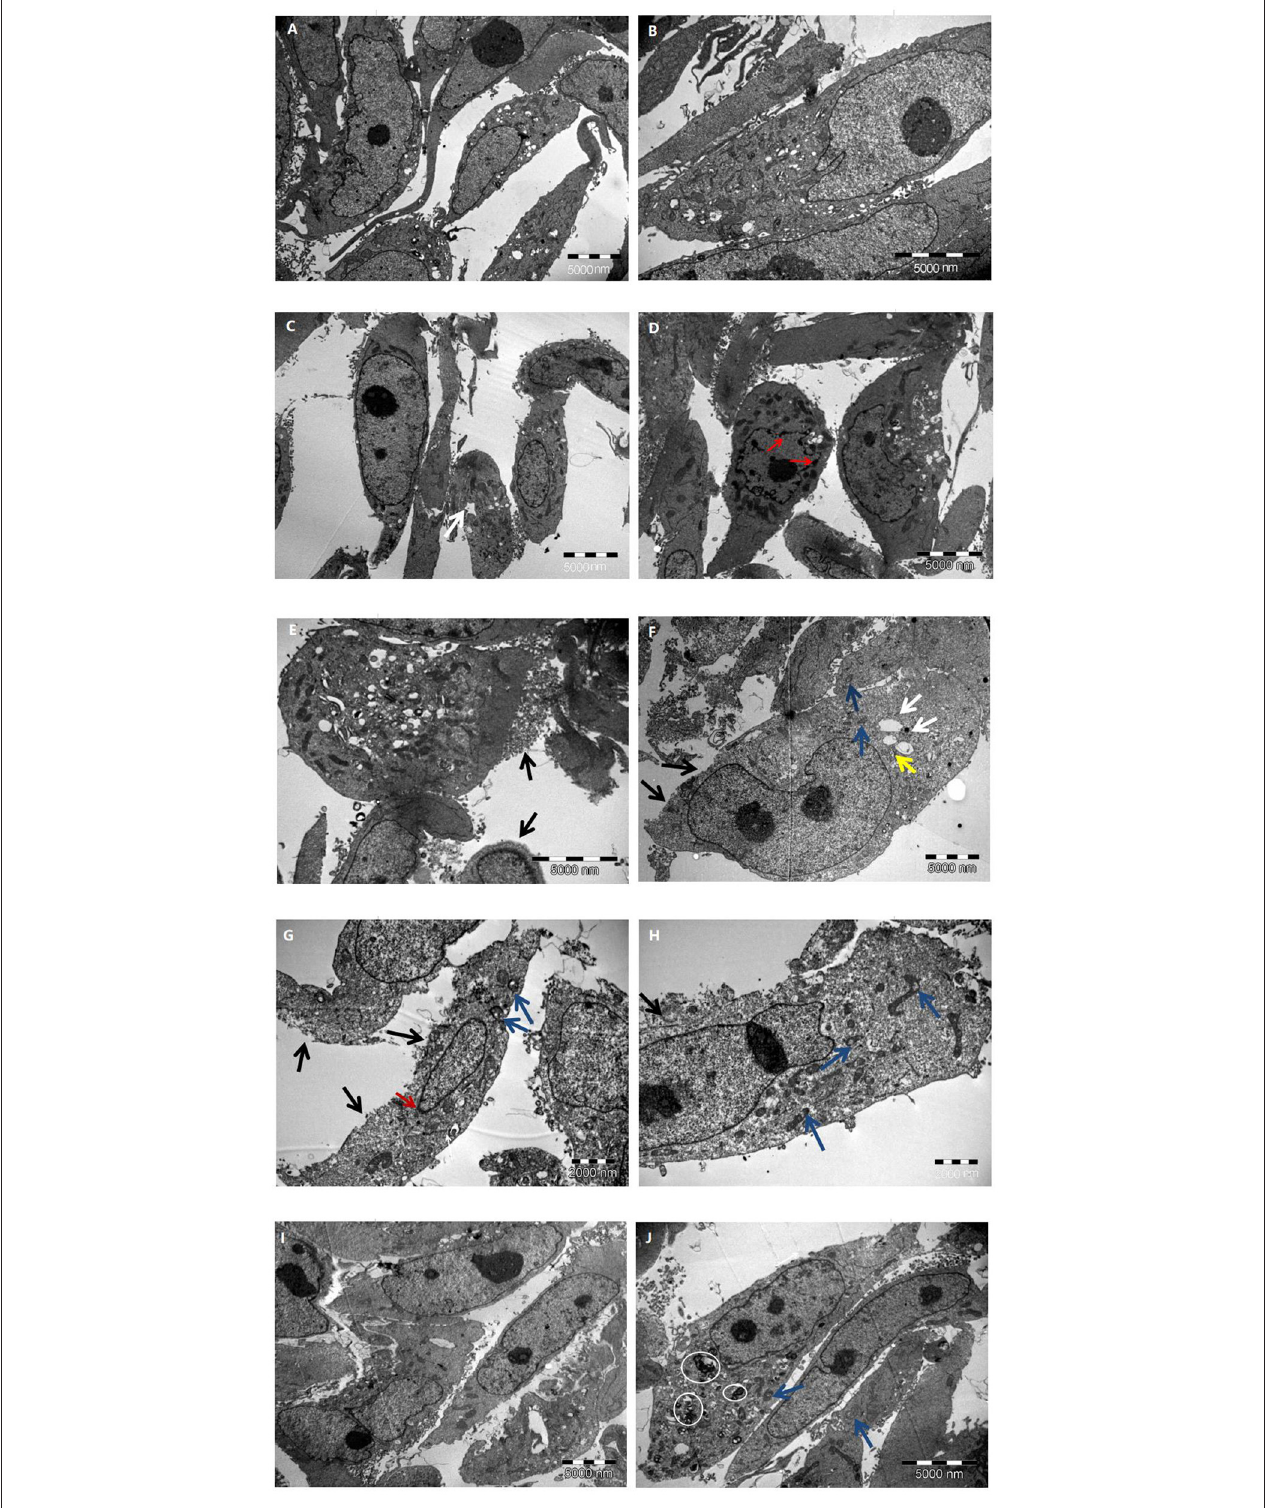
FIGURE 4 | The characteristic of HK-2 cells at different glucose concentrations. (A,B) Control group; (C–E) 15 mmol/L glucose group; (F–H) 30 mmol/L glucose group; (I,J) 45 mmol/L glucose group. Black arrow: cell membrane injure; White arrow: endoplasmic reticulum vesiculated expansion; Blue arrow: mitochondrial vacuolation; Yellow arrow: Golgi swelling; Red arrow: chromatin marginated; White circle: myeloid structure.